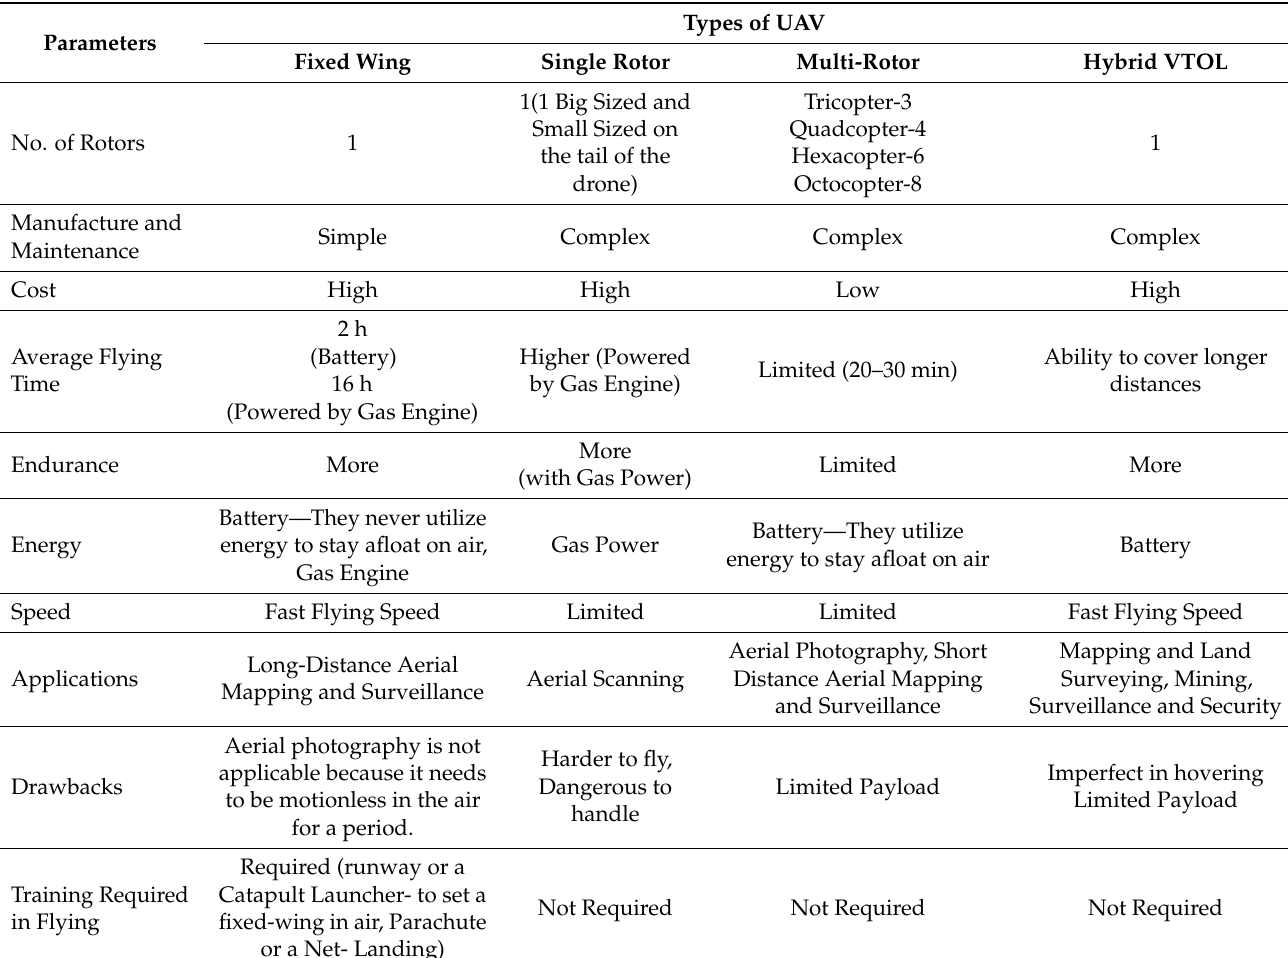
Table 2. Comparison of Types of UAV.